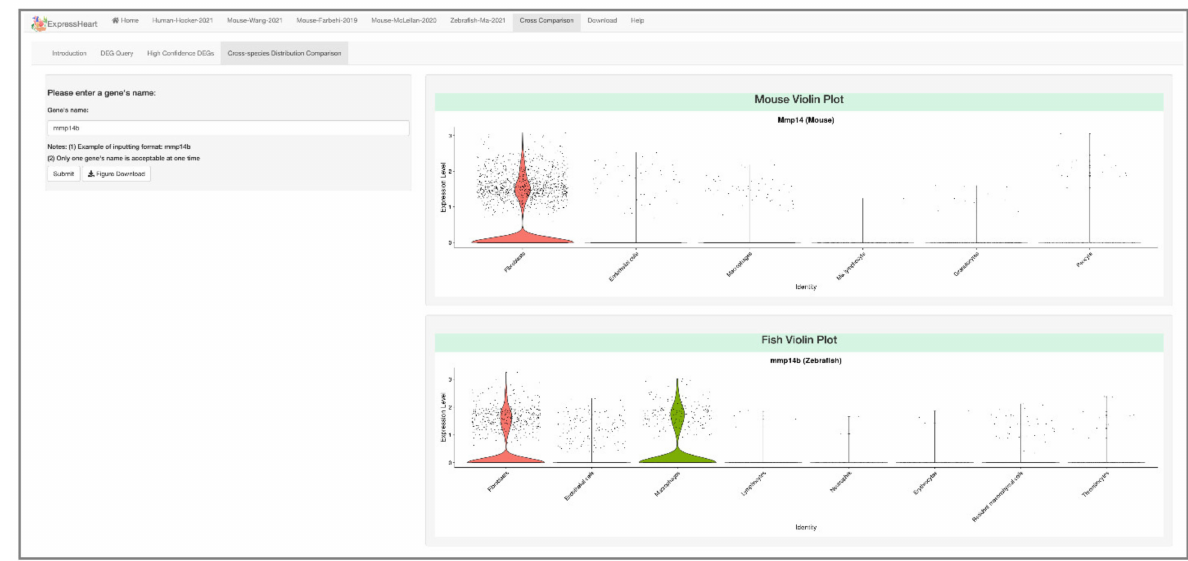
Figure 7. Cross-species comparison between mouse and zebrafish datasets. Users can input the homolog gene name on the left panel, and the corresponding violin plots for the homolog genes ( mmp14b in zebrafish, and Mmp14 in mouse) are shown on the right. Here, mmp14b is expressed in 28.0% and 27.8% of fibroblasts and macrophages of zebrafish, while its homolog gene Mmp14 is expressed in a similar proportion of fibroblasts (28.5%), but in a much lower proportion of macrophages (0.9%) of